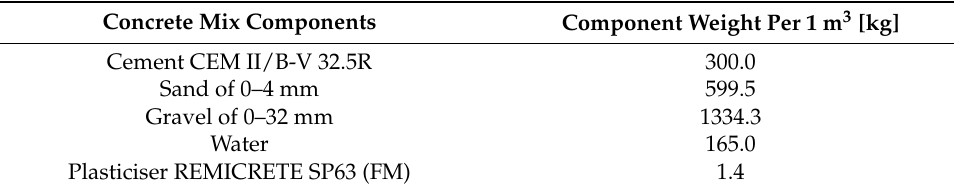
Table 1. Recipe of the concrete mix for series